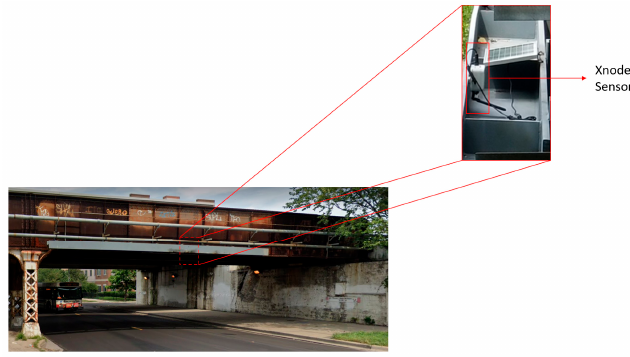
Figure 3. Low-clearance railroad bridge instrumented with the Xnode.